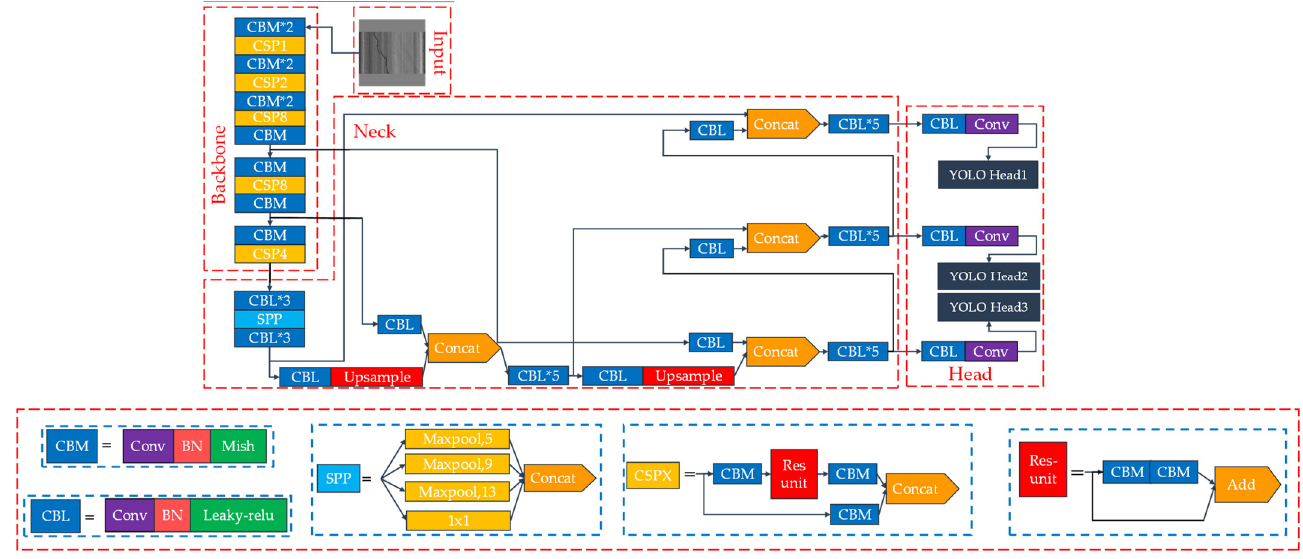
Figure 2. YOLOv4′s structure chart. Figure 2. YOLOv4 (cid:48) s structure chart.